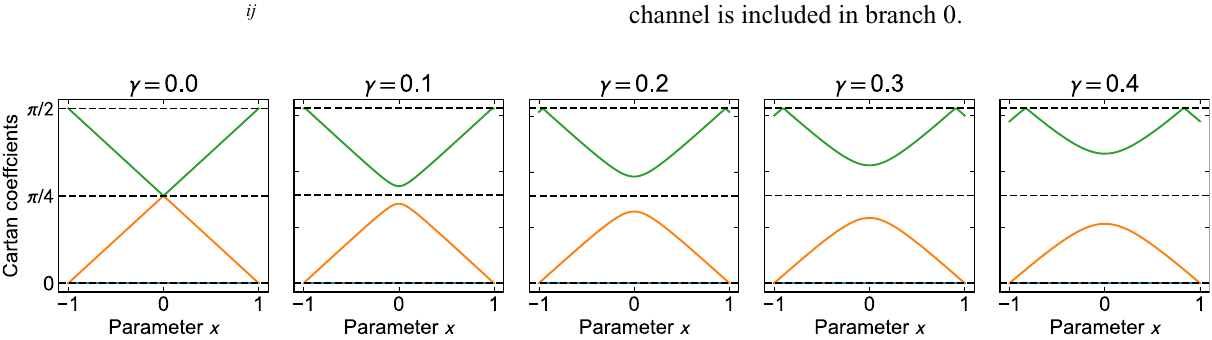
FIG. 7. Cartan coefficients of unitary gate generated by CCR drive with a static ZZ error γ ZZ (γ ∈ [0, 0.4] ) , while the ratio between the bidirectional CR drive amplitudes ( 1 − x ) : ( 1 + x ) is swept ( x ∈ [ − 1, 1]). Each line color corresponds to a Cartan coefficient; namely, there are three lines, for c 1 , c 2 , and c 3